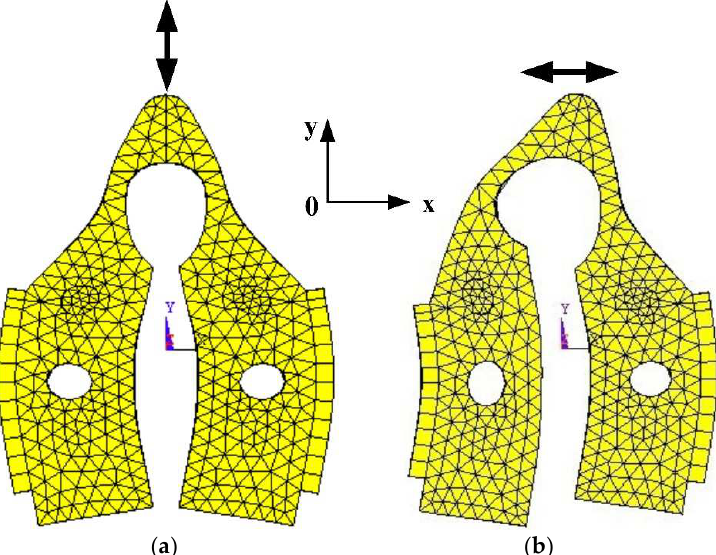
Figure 9. Modal analysis after optimized structure: ( a ) Anti-symmetrical modal analysis; ( b ) Sym- metrical modal analysis.